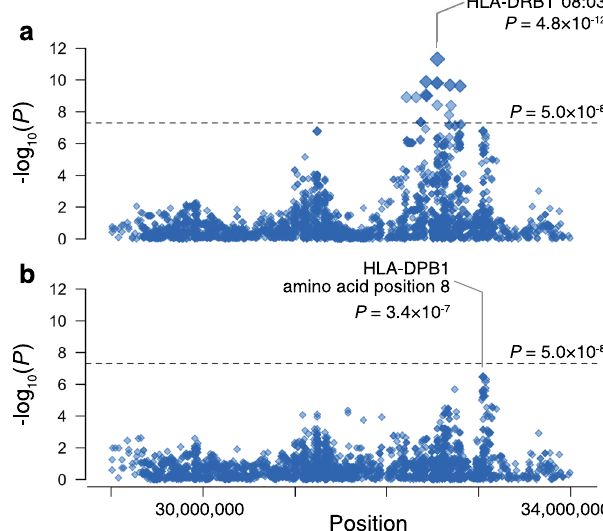
Fig. 2 Regional associations of the variants in the major histocompatibility complex (MHC) region with autoimmune pulmonary alveolar proteinosis risk. Regional associations of the variants in the MHC region with aPAP risk based on the HLA imputation analysis. a Each diamond represents the − log 10 ( P ) of association of the variants, including the single nucleotide polymorphism, two-digit and four-digit HLA alleles, and amino acid polymorphisms of HLA genes. The dotted horizontal line represents the genome-wide signi fi cance threshold of P = 5.0 × 10 – 8 . The lead HLA allele is labeled. b Each diamond represents the – log 10 ( P ) of the secondary associations after conditioning on the dosage of the lead variant HLA-DRB1*08:03. The dotted horizontal line represents the genome-wide signi fi cance threshold of P = 5.0 × 10 – 8